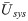
Hydrodynamic parameter distribution computed along the spine for cynomolgus monkeys.(A) Reynolds number, Re, (B) Flow rate amplitude, Qa, (C) Stroke Volume, SV, (D) left axis, Hydraulic diameter, Dh, right axis, Womersley number, α, (E) mean peak systolic, U¯sys, and diastolic, U¯dia, CSF velocity. Mean value for all 16 NHPs corresponds to the solid line. Dotted lines correspond to ± 1 standard deviation for all 16 NHPs analyzed.